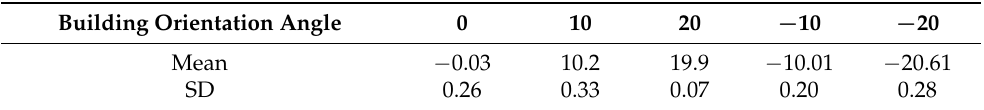
Table 5. Our proposed approach building orientation angle estimation mean and SD values with building image contrast